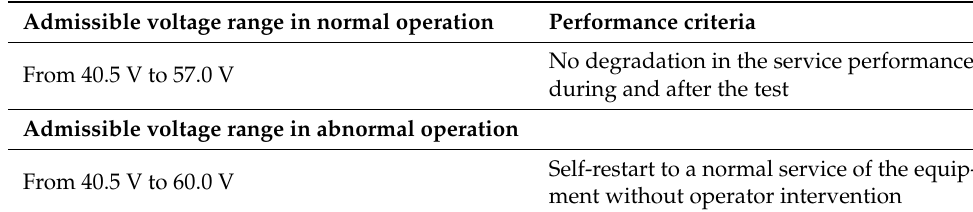
Table 1. Normal and abnormal service voltage interval at the interface “ A x ” according to the standard “ETSI EN 300 132:part 2”